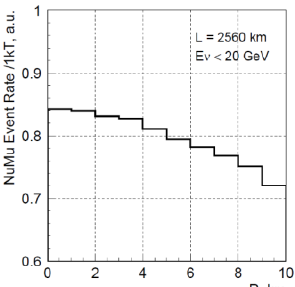
Figure 7. Distribution of neutrino interactions perpendicular to the beam at the ORСA